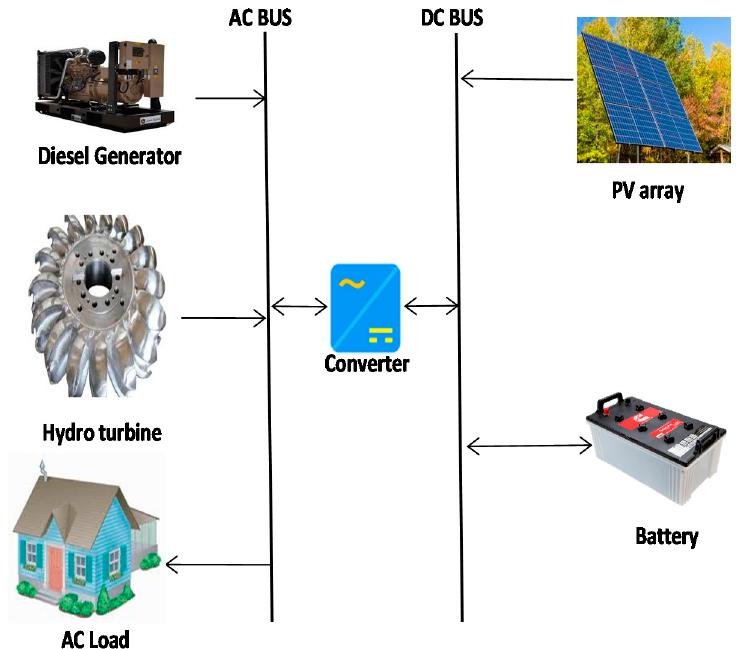
Figure 2. Schematic diagram of the proposed photovoltaic (PV) / hydro / diesel / battery hybrid energy system (HES).